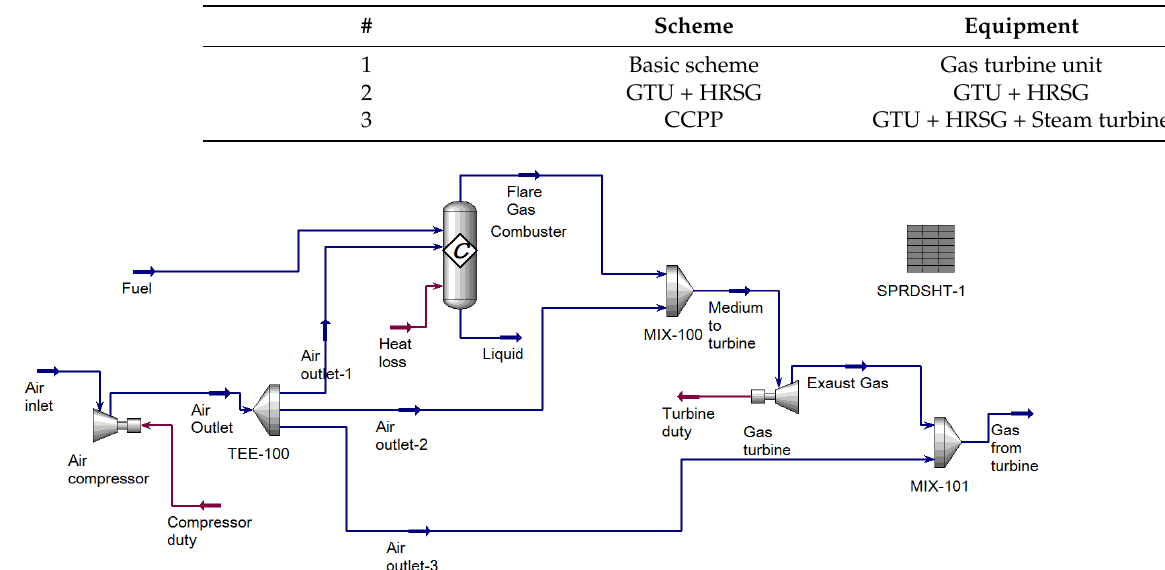
Table 2. Description of the schemes under consideration.